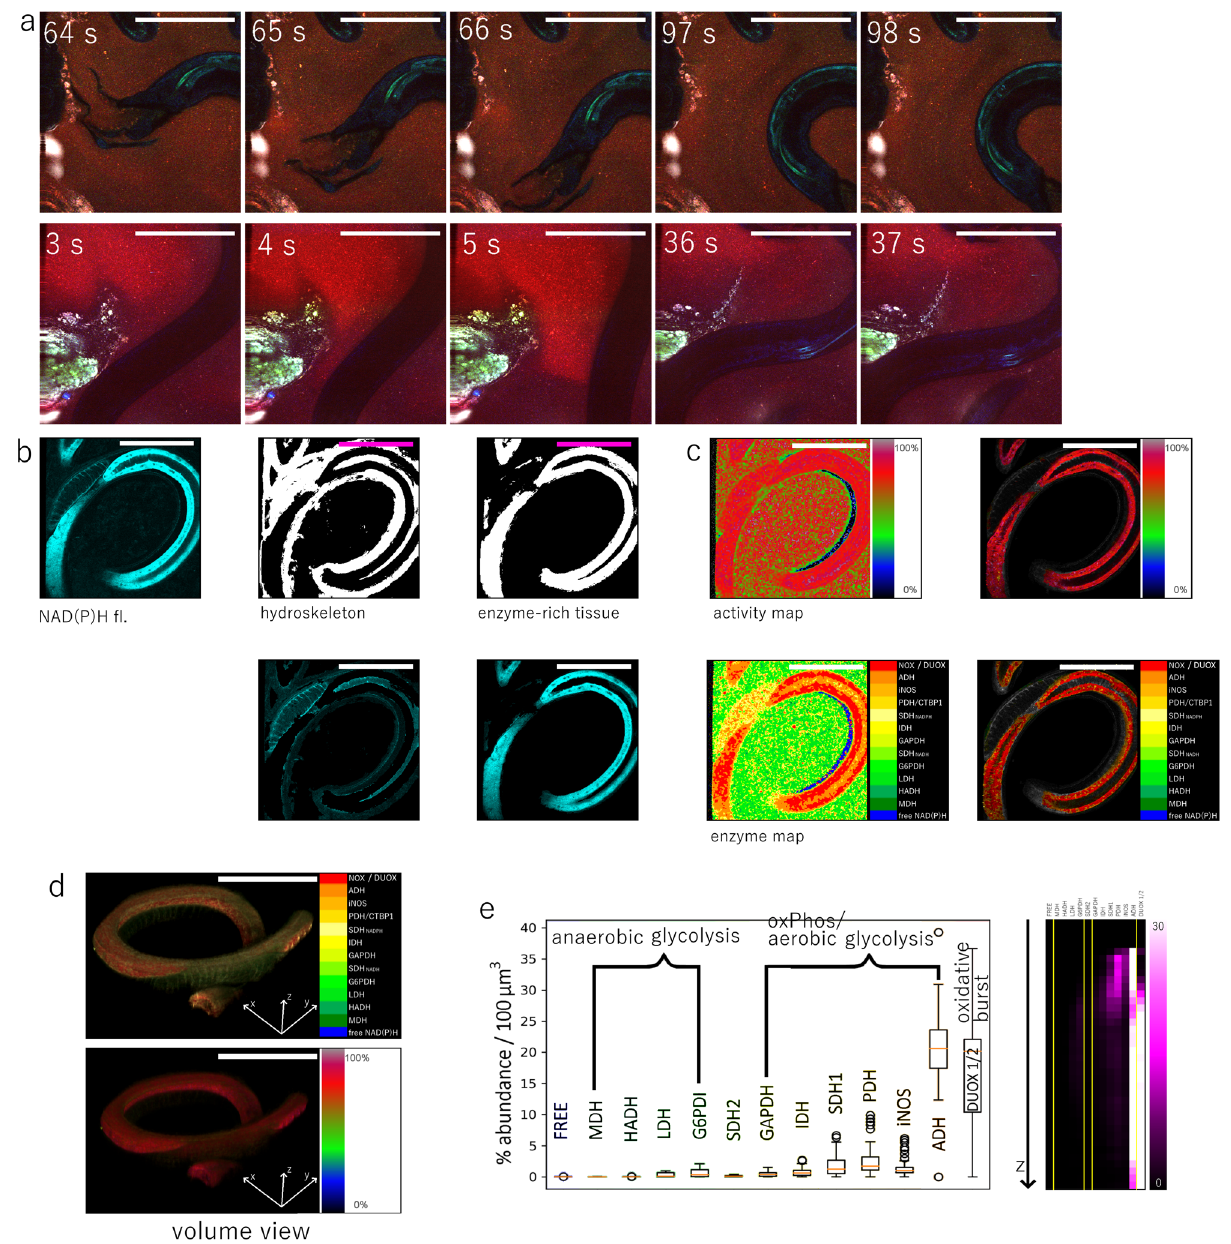
Figure 4. NAD(P)H fluorescence lifetime imaging of H. polygyrus in intestinal environment. (a) Snapshots (500 × 500 µm images) of H. polygyrus movement in the murine intestinal lumen. Endogenous fluorescence of parasite and host villi (green and blue), BODIPY1 fluorescence in mucus (red). λ exc = 920 nm. (b) Representative NAD(P)H fluorescence sum image (500 × 500 × 100 µm 3 ) and segmentation of the worm compartments, differentiating between hydro-skeleton (low NAD(P)H fluorescence) and worm tissue (NAD(P)H-rich areas). (c) Enzyme and activity maps of the entire NAD(P)H signal (right panel) and masked enzyme and activity maps of the NAD(P)H-rich worm tissue (left panel). (d) 3D reconstructions of the enzyme and activity maps shown in the left panel in (c) . (e) Frequency graph of enzymatic activity in the entire parasite and depth-dependent frequency representation of enzymatic activity. Scale bar for all images = 250 µm. Figure generated with Paint. NET, https:// www. getpa int. net/ downl oad. their locomotion upwards in the small intestine and their survival in the duodenal luminal niche. In order to understand the energetics governing their motility behavior, we aimed to investigate NAD(P)H metabolism of nematodes by NAD(P)H-FLIM. Using the same pixel classification approach as previously described, the nematode hydrostatic skeleton and its cellular, NAD(P)H-rich tissue were segmented from the NAD(P)H intensity images of H. polygyrus in the murine duodenum (Fig. 4b). The resulting mask was used to generate metabolic and enzyme 2D and 3D maps of the